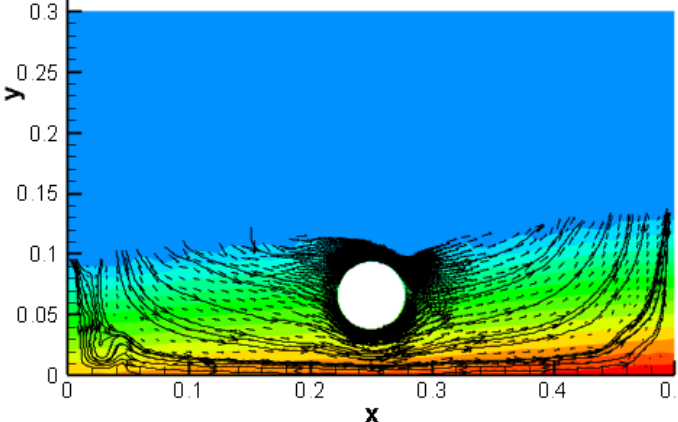
Figure 5. Pressure and velocity in liquid for filling level = 37% and 0.6 × h f distance from bottom at t = 1 × ( s )